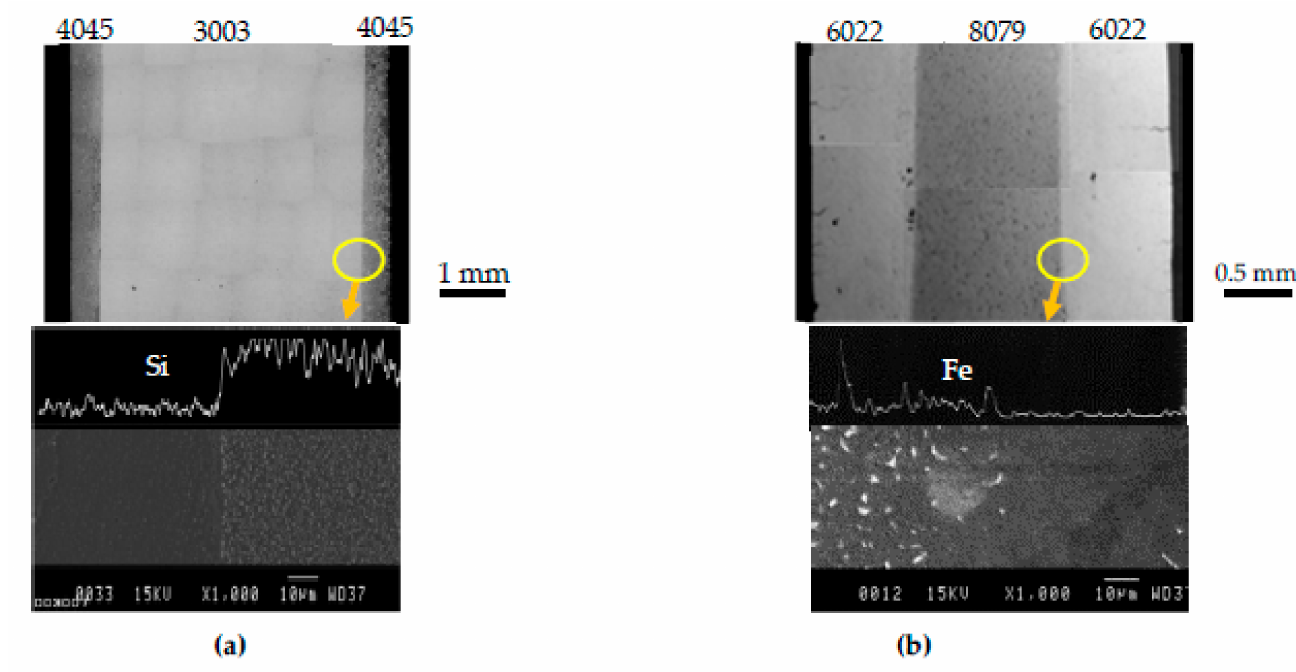
Figure 17. Line analysis at interface between base strip and overlay strip. ( a ) 4045/3003/4045 clad strip, ( b ) 6022/8079/6022 clad